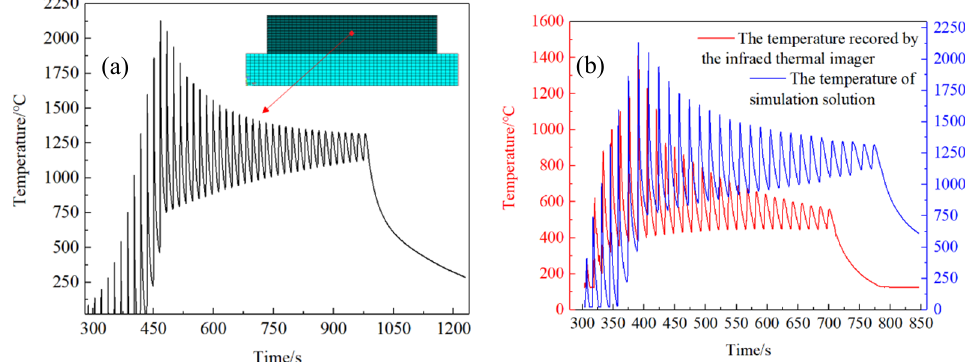
Figure 14. ( a ) Temperature-time history of the surface center point in the AM process of thin-walled parts solved by ANSYS. ( b ) Comparison of temperature experiment results and simulation results of 316L stainless steel thin-walled parts formed by laser cladding.